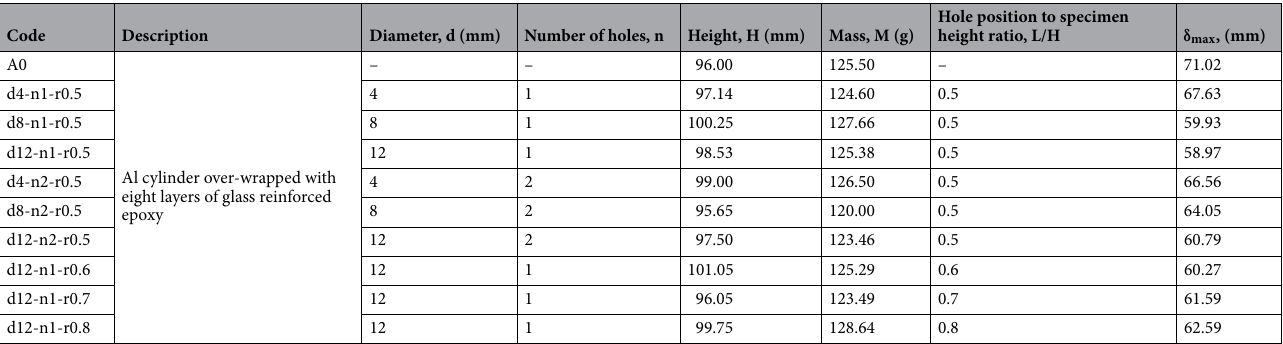
Table 4. Description of the fabricated Al/GFRP hybrid tubes with induced holes. The letters “d”, “n” and “r” in the specimen code represent the diameter and number of the holes and position to height ratio, respectively. For examples, “A0” means Al-cylinder over-wrapped with eight glass/epoxy layers with no holes. d4-n2-r0.5 means Al-cylinder over-wrapped with eight glass/epoxy layers with two opposite holes with 4 mm diameter and 0.5-hole position to height ratio.